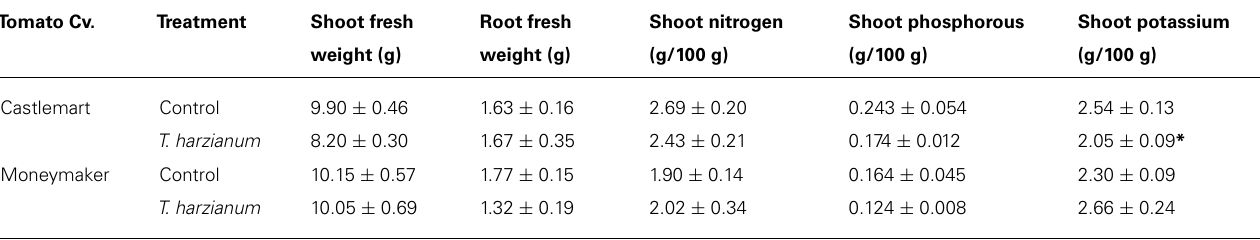
Table 2 | Effect of Trichoderma harzianum on tomato plant development. Shoot and root fresh weight (in grams) and shoot nitrogen, phosphorous, and potassium content (g/100 g fresh weigh) of 5-weeks old tomato lines Castlemart and Moneymaker inoculated with T. harzianum